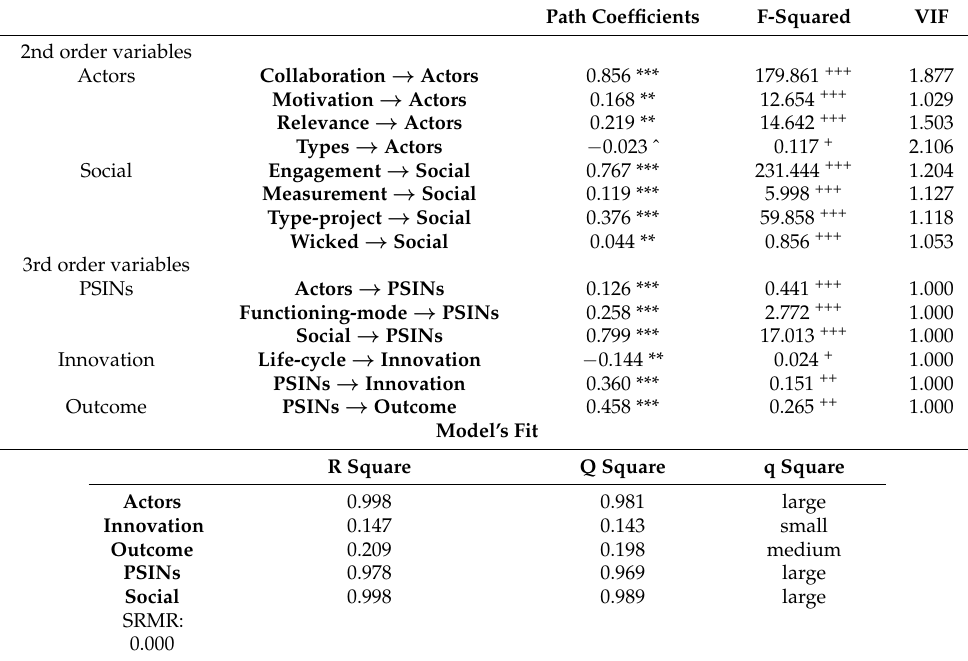
Table 1. Path coefficients, F-square and VIF of the constructs, by their higher order component, for the pooled